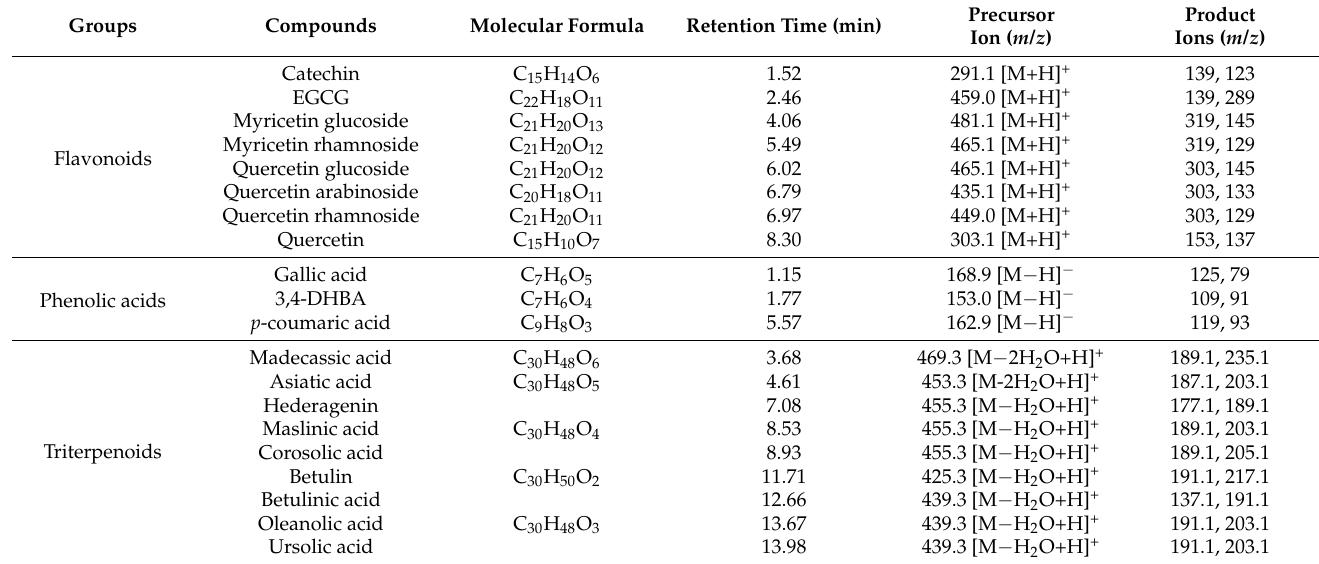
Table 2. List of phenolic compounds and triterpenoids detected in Syzygium formosum leaves by UPLC-MS/MS. Groups Compounds Molecular Formula Retention Time (min)